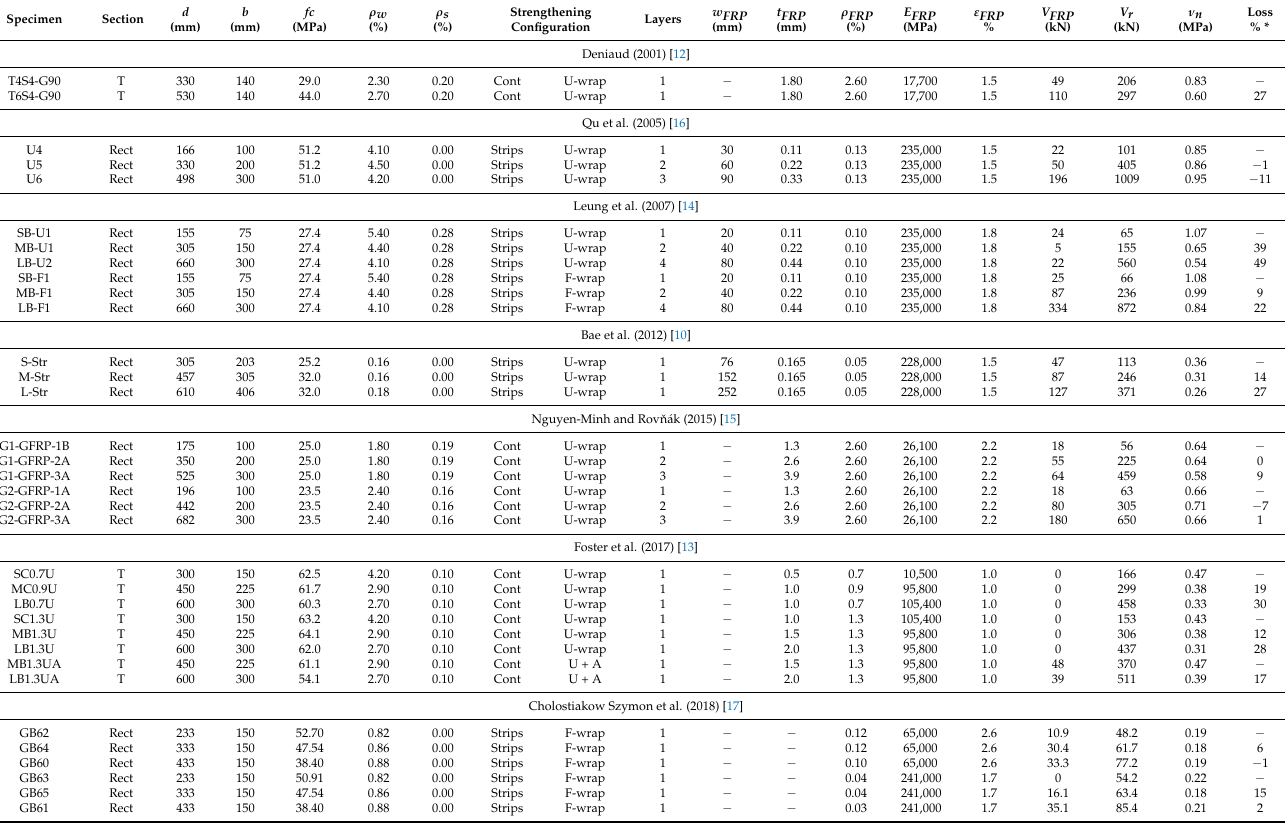
Table 6. Details of shear-strengthened specimens from